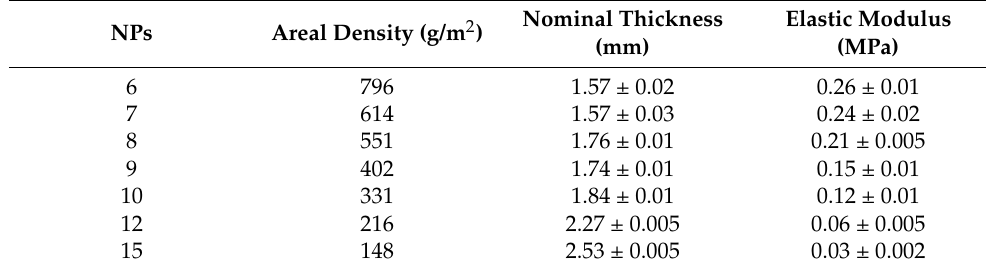
Table 3. The areal density and elastic modulus of the knitted sample series of NP x Y S 1 C 2 E 1